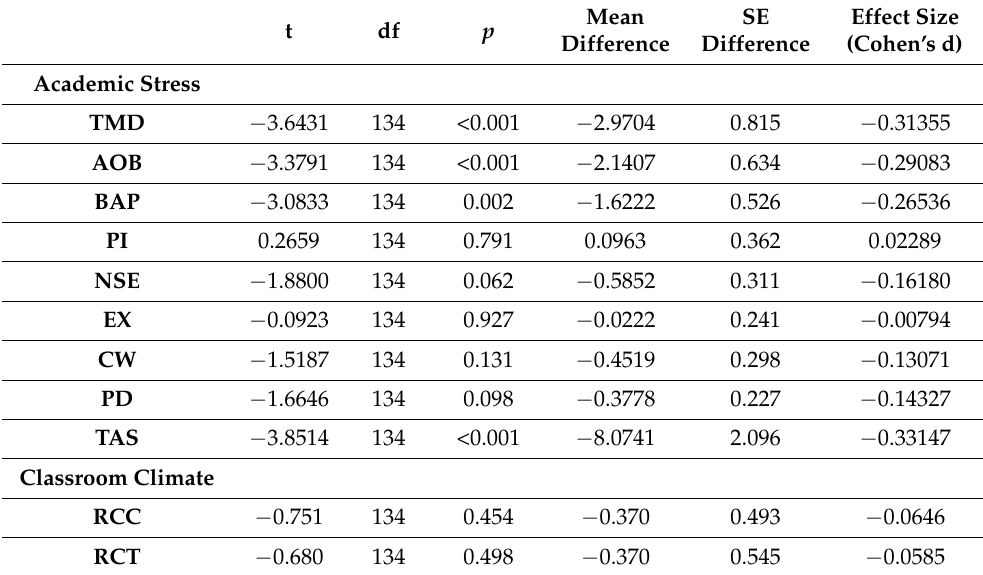
Table 3. Differences in academic stress and perceived classroom climate in Time 1 (before lockdown declaration) and Time 2 (after